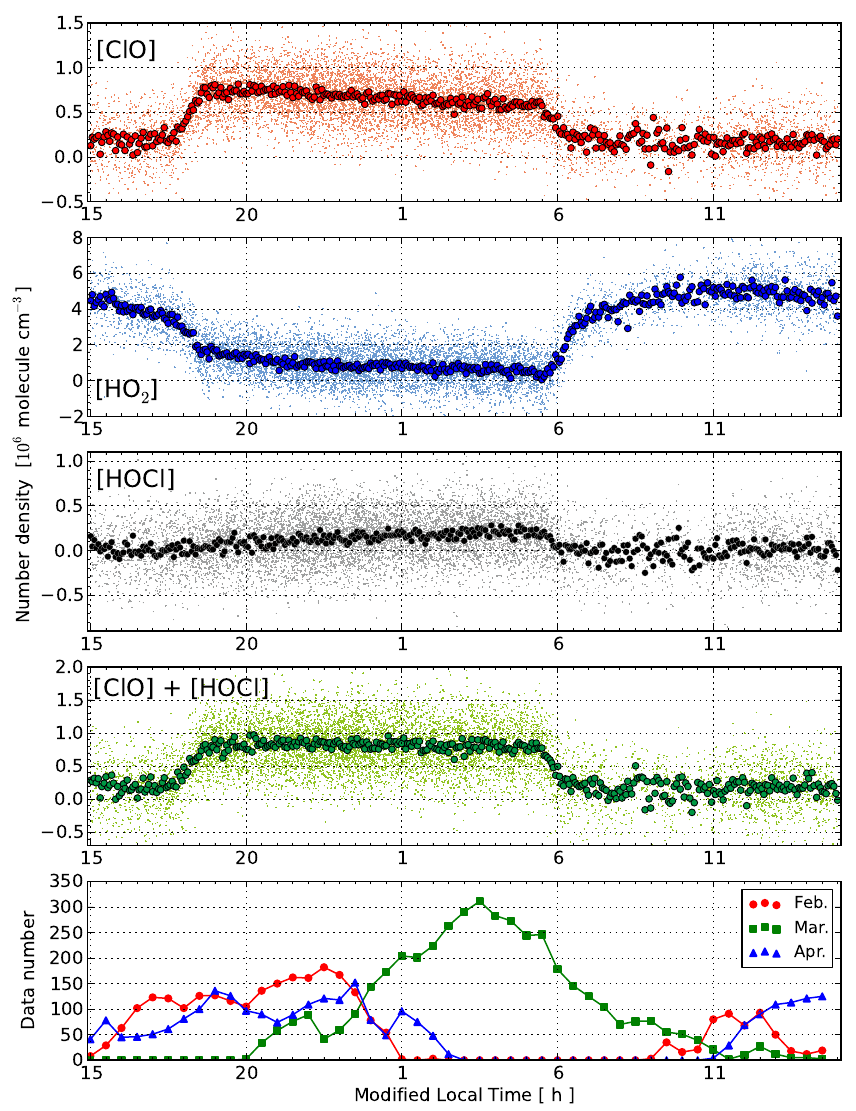
Fig. 2. Diurnal variation of the number density of ClO, HO 2 , HOCl, and the sum of [ClO] and [HOCl] at 0.28hPa obtained by SMILES. Data from 20–40 ◦ S from February to April 2010 are used in this study. Small dots represent the results from each single measurement of SMILES. Large dots show the smoothed temporal evolution with an average over 3.75min. The modified local time dependence of the number of data is shown in the bottom panel. The number of data is integrated over every 0.5h for February (red), March (green), and April (blue) separately.